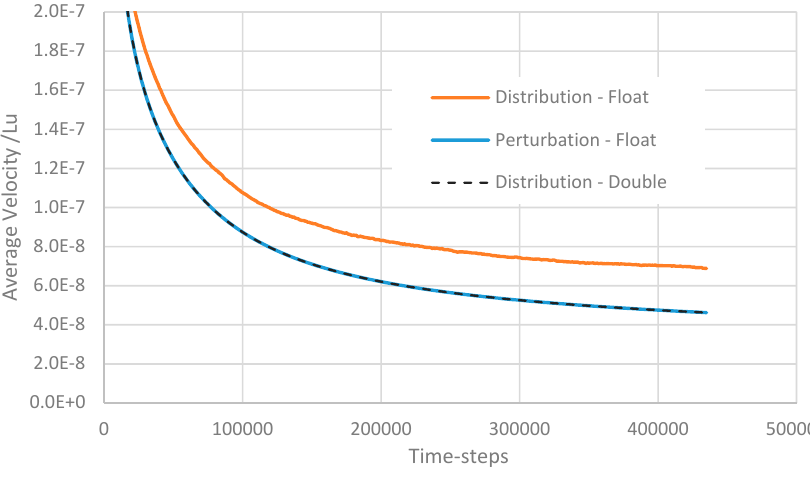
Figure 7. The average velocity throughout the Portland carbonate sample over the simulation. Points are sampled every 1000 time-steps.